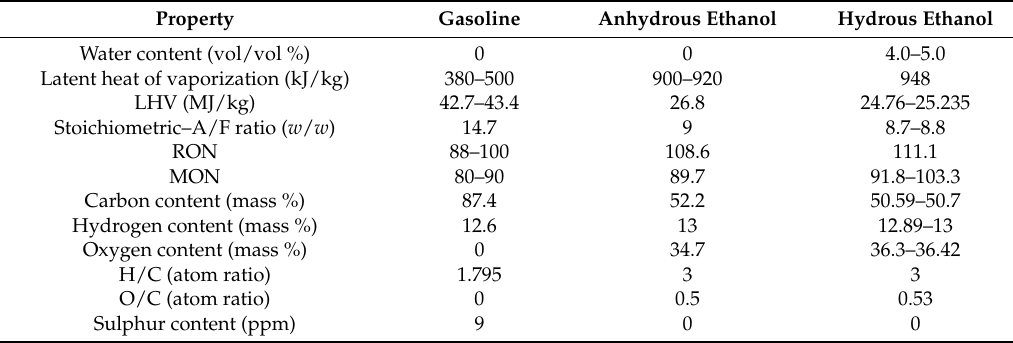
Table 2. Properties of gasoline, anhydrous, and hydrous ethanol fuels